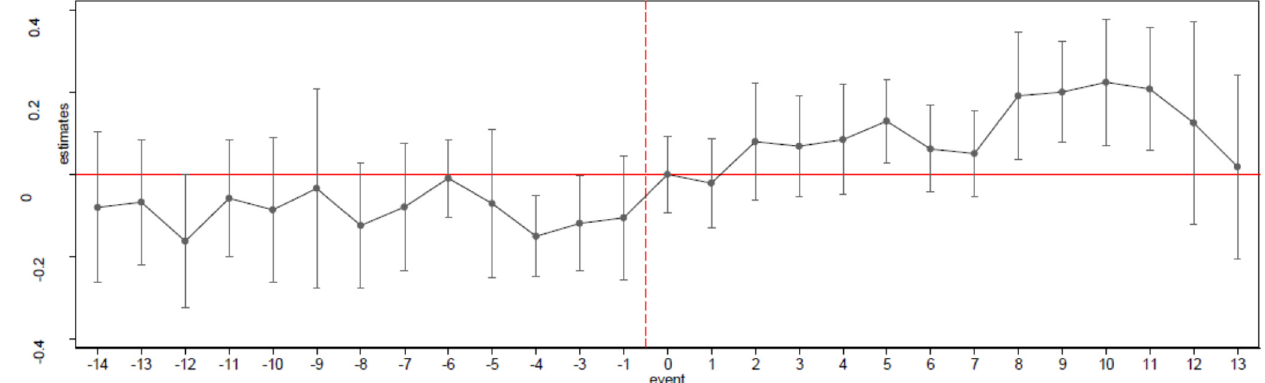
Figure 6. Parallel Trends Analysis – Event Studies on Loans Granted - Retail Sector.